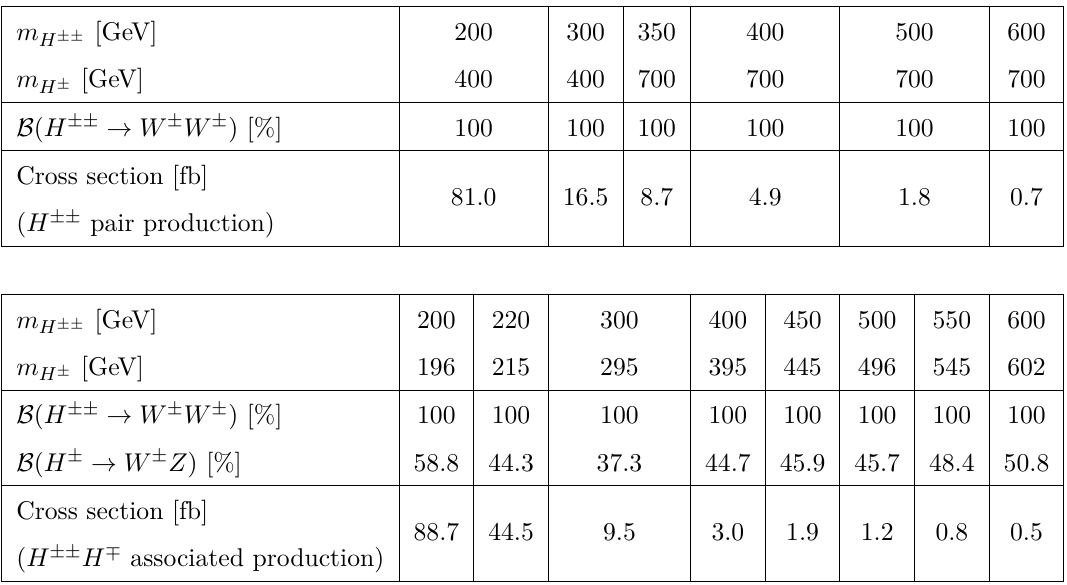
Table 1 . The cross sections for the H ±± pair and the H ±± and H ± associated production modes at next-to-leading order in QCD [52]. The branching ratios ( B ) of the charged Higgs bosons to W ± W ± or W ± Z are included in the quoted values.